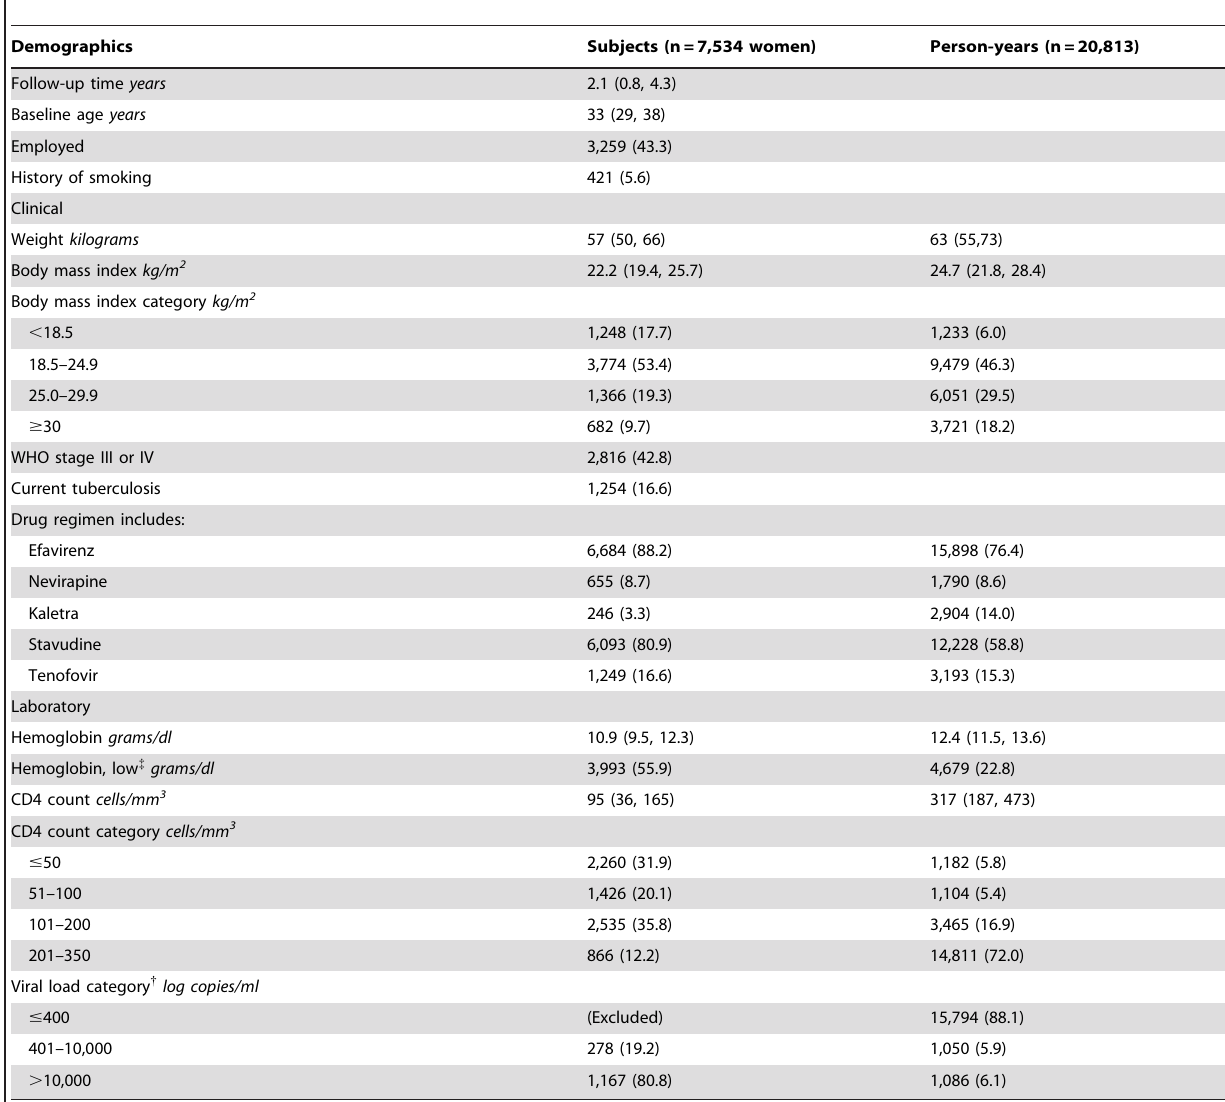
Table 1. Characteristics of 7,534 women initiating HAART in Johannesburg, South Africa from 1 April 2004 to 31 March 2011, at study entry and contributed during 20,813 person-years of follow-up